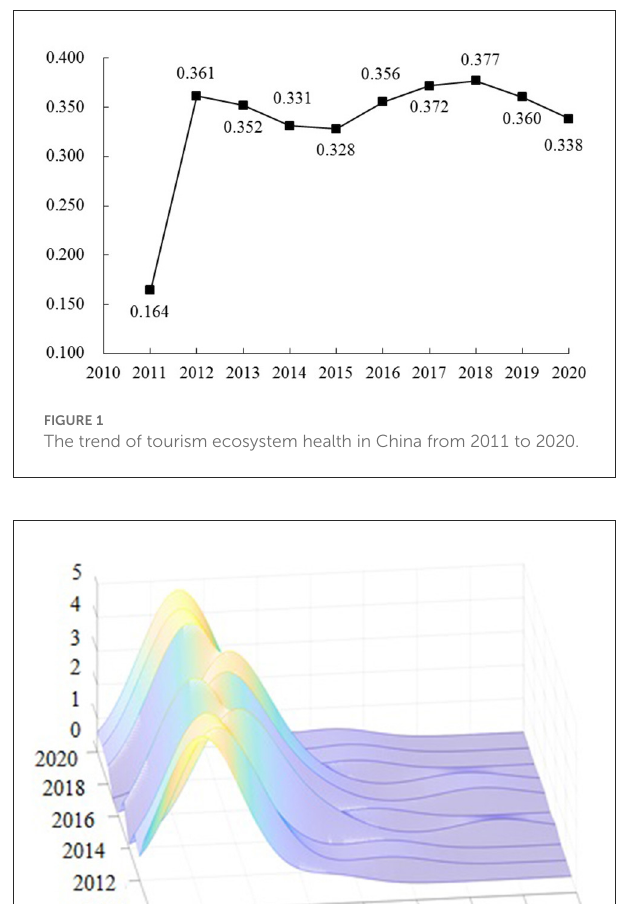
FIGURE2 The Kernel density estimation of tourism ecosystem health in China.